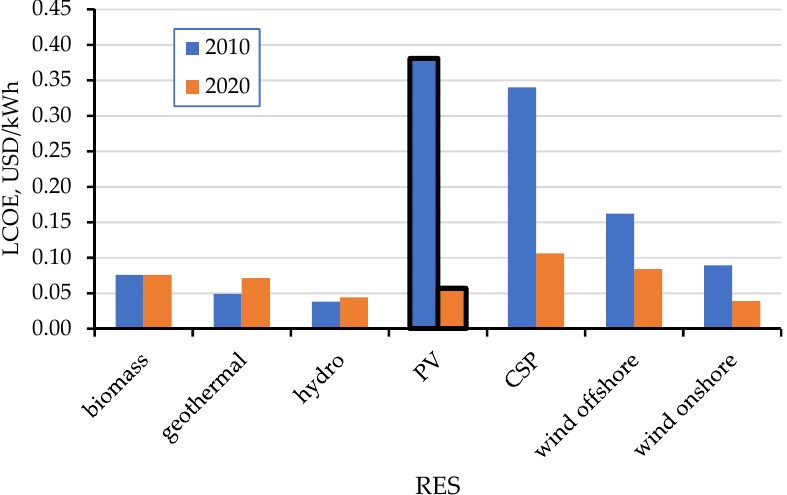
Figure 4. Trends in unit investment in RES technologies (CSP—concentrated solar power, hydro— hydroelectric power station). Source: own study based on [31].